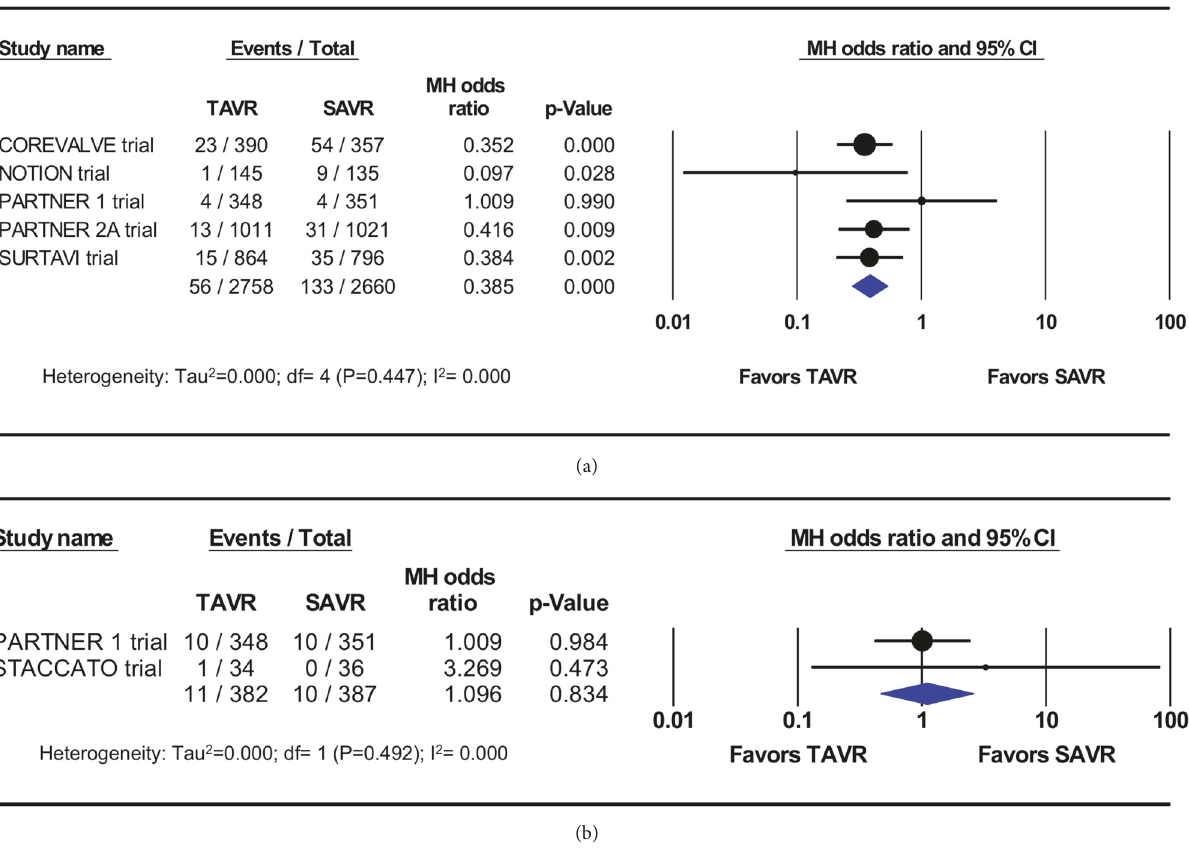
Figure 4: Pooled effect estimates for 30-day acute kidney injury and renal replacement therapy according to the type of aortic valve replacement procedure in the randomized controlled trials. TAVR: transcatheter aortic valve replacement, SAVR: surgical aortic valve